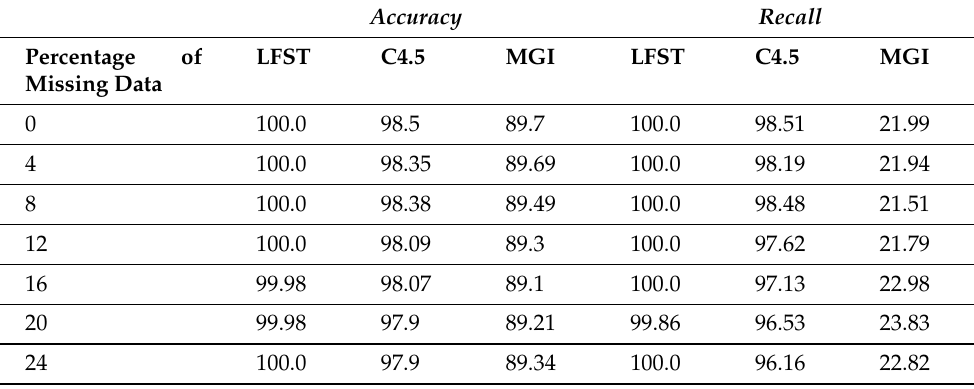
Table 2. Average accuracy and recall for the three algorithms in